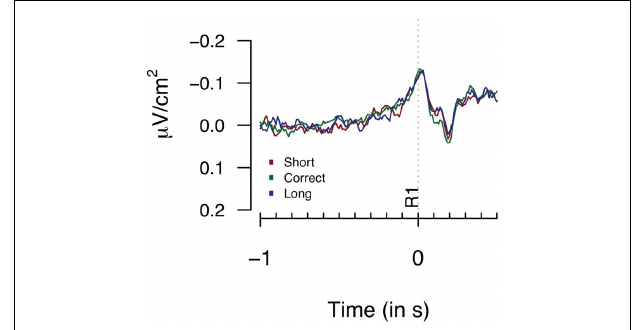
FIGURE 2 | Laplacians obtained at FCz during Experiment 1 as a function of participants’ behavioral performance, plotted time-locked to the first key press (R1). Averages are based on nine participants who met the “3-in-a-row” criterion.